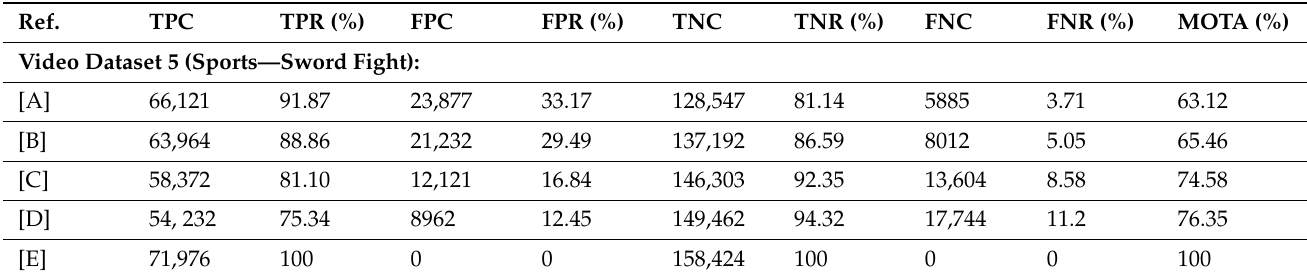
Table 5. Comparison of performance parameters by different approaches tested on video dataset 5: [A] by Pan et al. in [12]; [B] by Mehboob et al. in [13]; [C] by Indu, S. in [14]; [D] our proposed approach; [E] the true data obtained using markers.